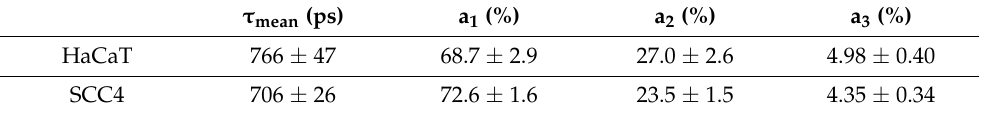
Table 2. Mean fluorescence lifetime ( τ mean ) and the associated exponential coefficients (a i ) of in- trinsic flavin autofluorescence in HaCaT and SCC4 monocultures, derived by an incomplete three- exponential fit decay analysis with fixed lifetime values: τ 1 = 250 ps, τ 2 = 1.4 ns and τ 3 = 5